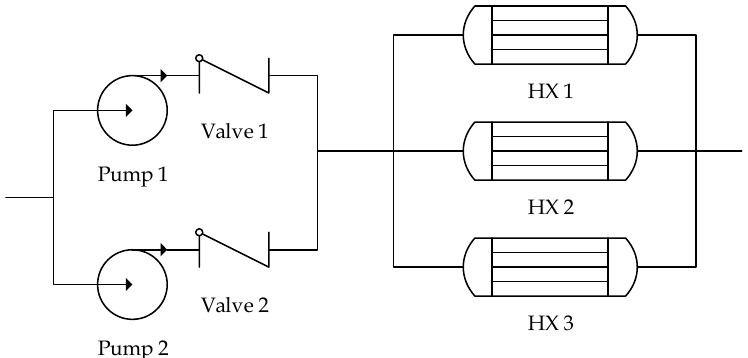
Figure 1. Typical alternating operation system.